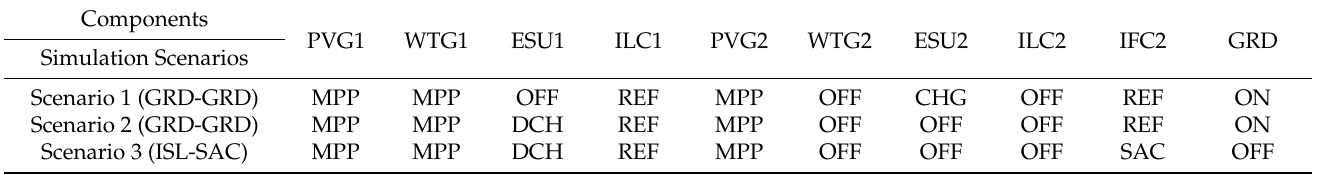
Table 9. Operation modes of the microgrid